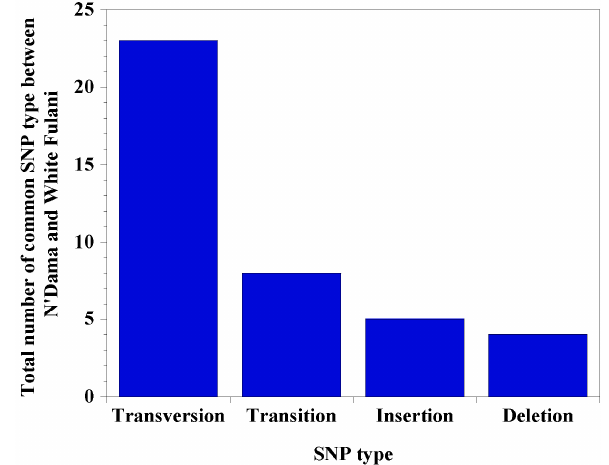
Figure 3. Total number of common SNP types between N’Dama and White Fulani. SNP types in the study include transversions (56.1%), followed by transitions (19.5%), insertions (12.2%), and deletions (9.8%). One SNP (2.4%) is a tandem repeat (not shown). Genes 2020 , 11 , x FOR PEER REVIEW